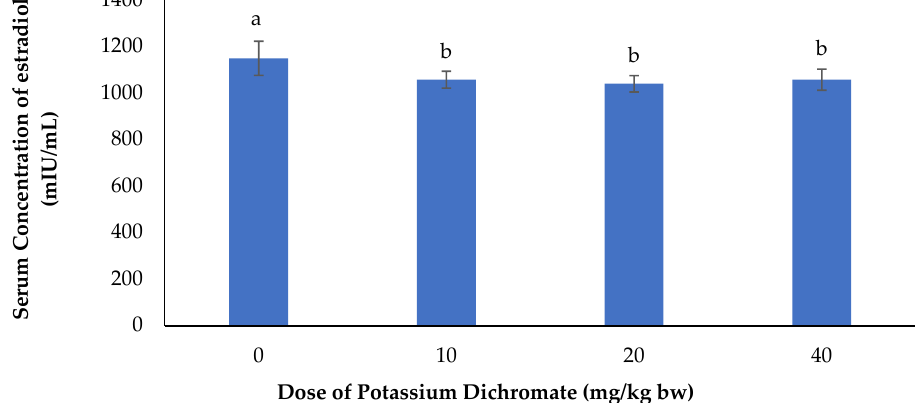
Figure 3. Effects of potassium dichromate on serum concentration of LH in rabbit does. a,b: bars affected with the same letter do not differ significantly ( p > 0.05).